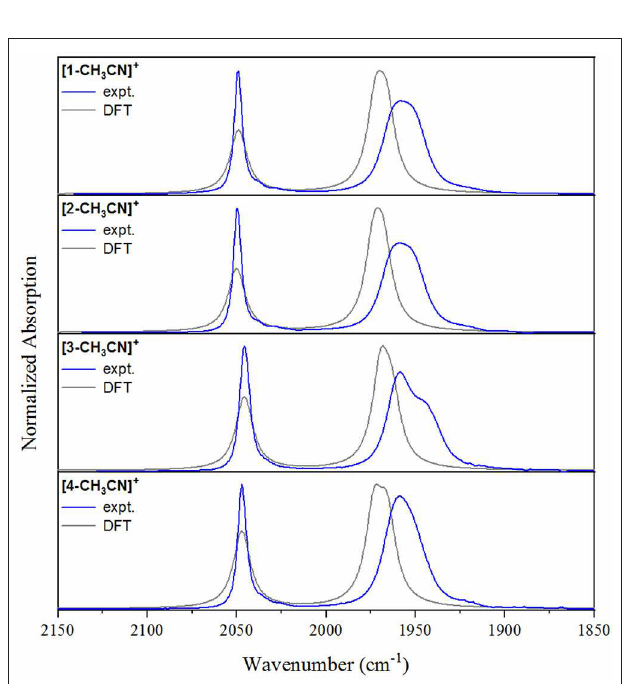
FIGURE 2 | Experimental FTIR spectra (blue) of [1-CH 3 CN] + , [2-CH 3 CN] + , [3-CH 3 CN] + , and [4-CH 3 CN] + recorded in acetonitrile displaying characteristic ν (CO) stretching modes. Density functional theory-computed IR spectra (gray) are included for comparison (empirically-derived frequency scaling factor = 0.9633, FWHM = 12 cm − 1 ).